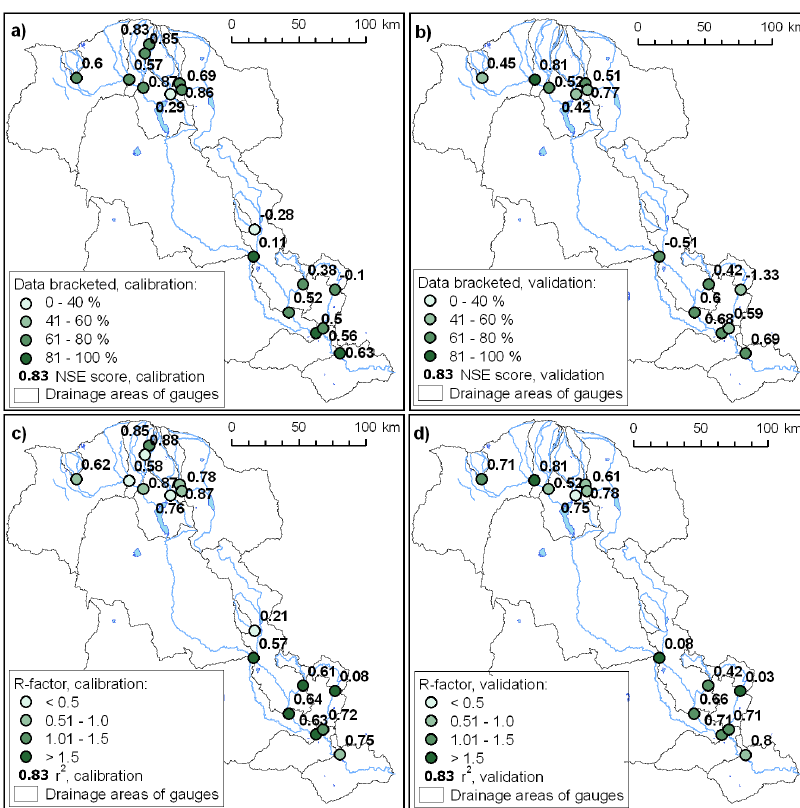
Fig. 4. SWAT-P calibration and validation results. (a) and (c) visualise the percentage of measured data bracketed by the 95% prediction uncertainty ( P -factor) for calibration (a) and validation period (c) ; (b) and (d) show the R -factor, i.e. the average thickness of the 95% prediction uncertainty, expressed in standard deviations of measured data for calibration (b) and validation (d) . The NSE scores and r 2 values reached in calibration and validation, respectively, are displayed as numbers.